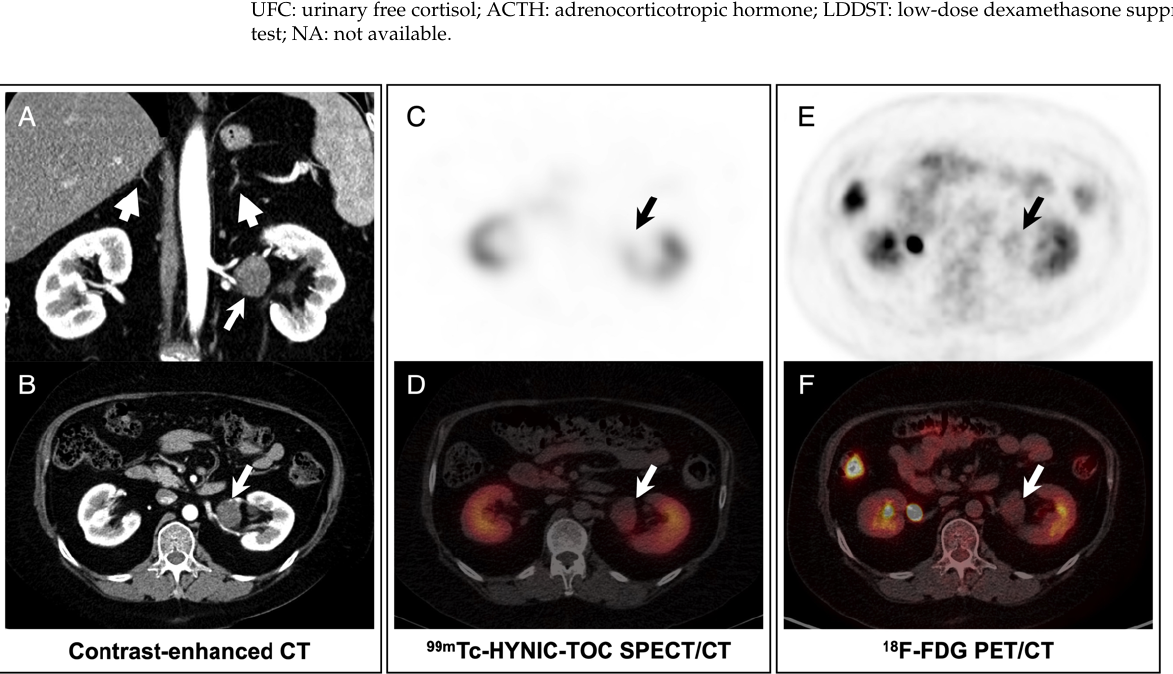
Figure 1. Imaging analysis of the patient. ( A , B ) Abdominal contrast-enhanced CT showed bilateral adrenal glands were atrophic without any nodules or hyperplasia (arrowheads), and a mass with mild enhancement in the left renal hilum (arrows). ( C , D ) 99m Tc-HYNIC-TOC SPECT/CT showed the mass was negative with somatostatin receptor imaging (arrows). ( E , F ) 18 F-FDG PET/CT revealed mild FDG activity of the mass (arrows).